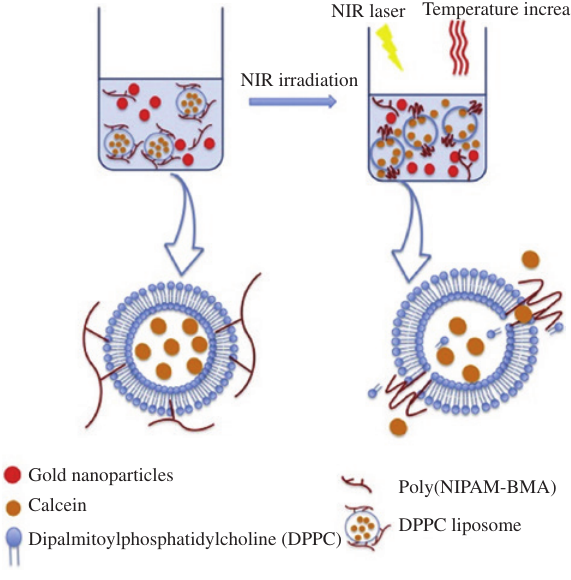
Figure 5: Schematic of gold NPs being excited by NIR radiation leading to drug release from thermosensitive liposomes. Reprinted with permission from Ref. [93], copyright 2015, Elsevier.